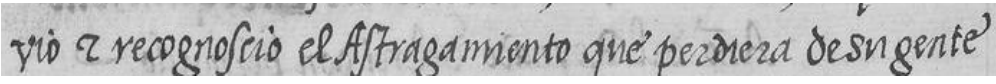
Figure 4. Text line sample. “Recognoscio” and “Astragamiento” are rare words; recognoscio is an archaic form of reconoció and Astragamiento an ancient form of Estragamiento